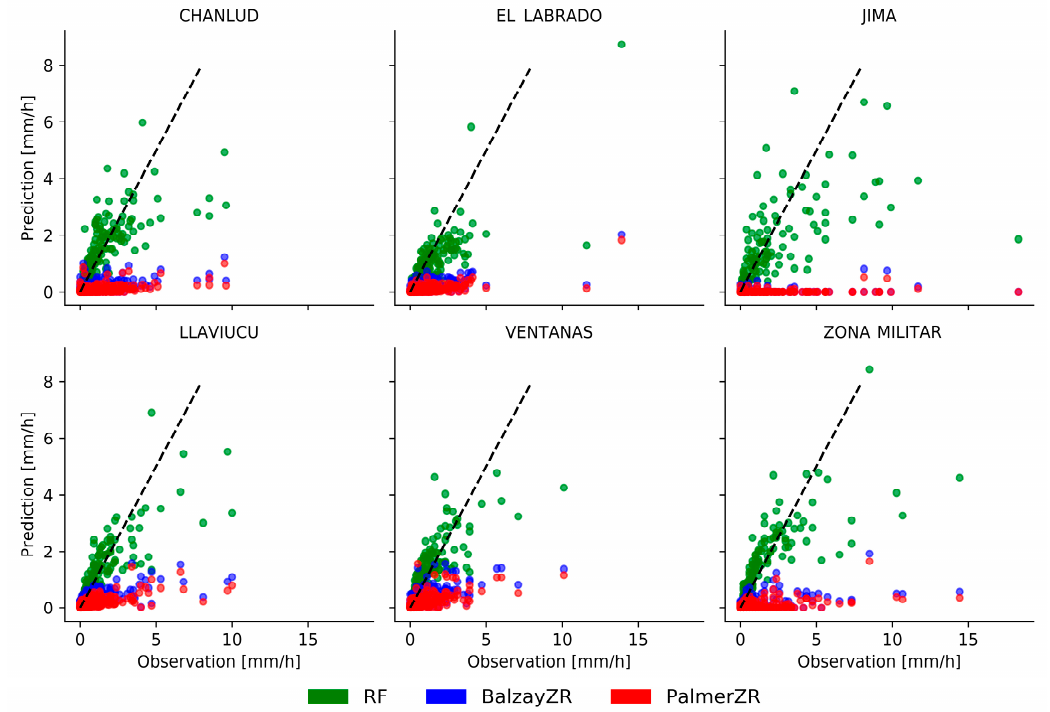
Figure 8. Scatter plot of observed rain rate vs. predicted rain rate for hourly accumulated rainfall at all six testing stations using the test data set (15 independent events). The 1-1 line is shown in black dotted. Three models are illustrated: random forest model (green), step-wise model using site-specific